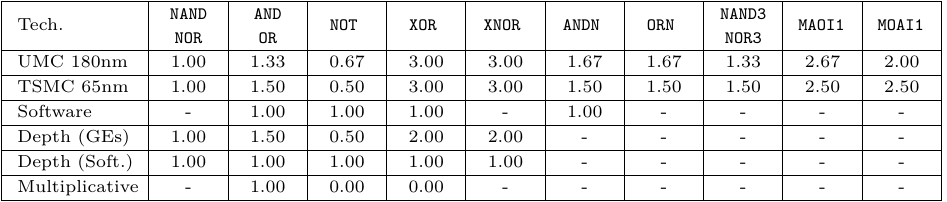
Cost of atomic operations under various techniques (some are referred from [JPST17])